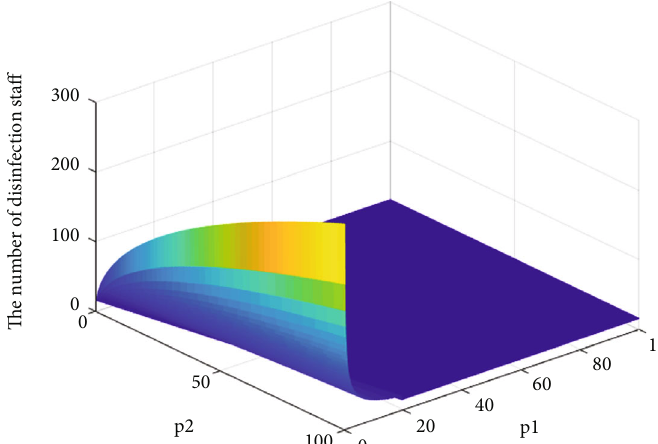
p 1 and 2 on the number of disinfection sta